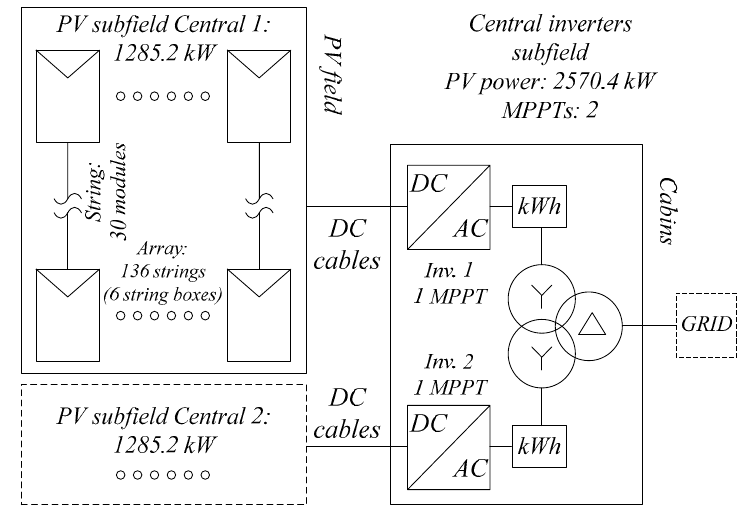
Figure 2. Scheme of the 2.5 MW subfield with central inverters.